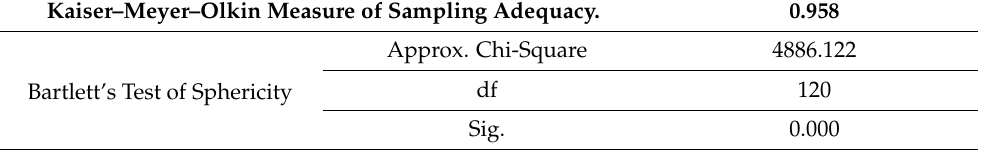
Table 7. KMO and Bartlett’s